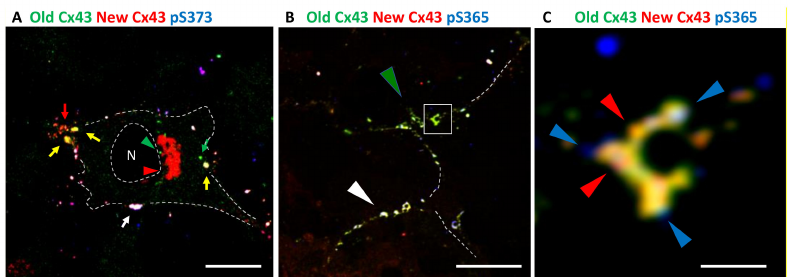
Figure 2. High-resolution Airyscan images of a pulse-chase experiment in NRK cells. Overlays show combined “old” Cx43 as green, “new” Cx43 as red and phosphospecific antibody (pS373 in ( A ) or pS365 in ( B , C )) staining in blue. Thus, white = old + new + Cx43, pS365 or pY247 Antibody. Yellow = old + new. Purple = new + phosphospecific. C is a higher magnification view of the boxed area in B. Dashed line encircling N indicates the approximate area of the nucleus. Other dashed lines indicate plasma membrane positions. Bar is 10 µ m in A and B and 1 µ m in C.